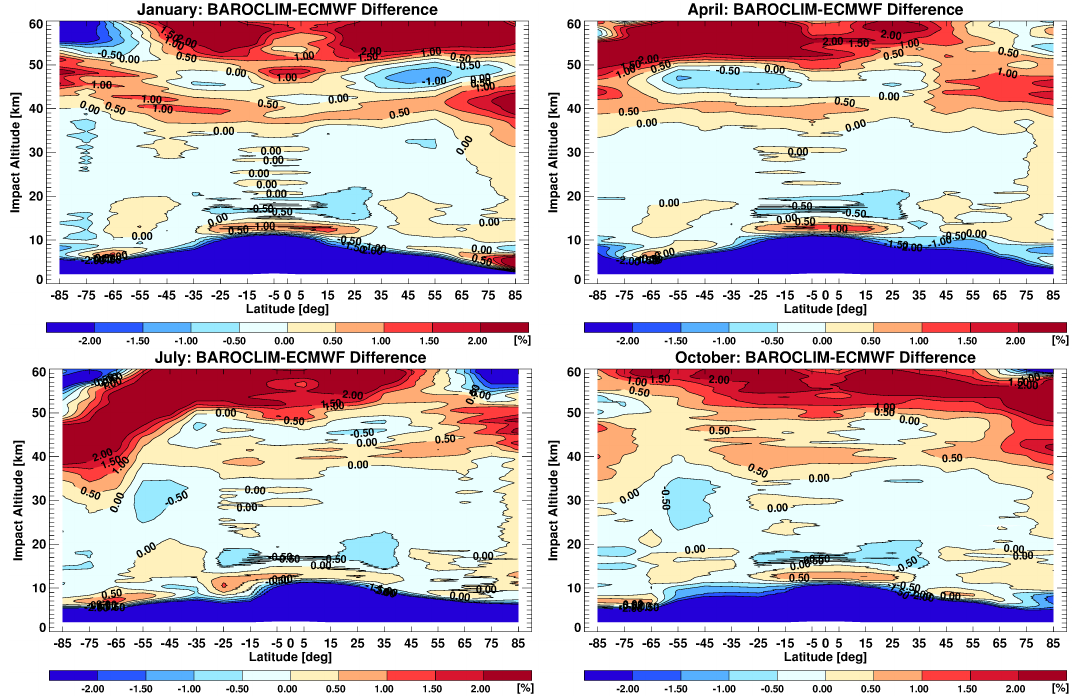
Figure 5. Systematic difference between the BAROCLIM spectral model and ECMWF analyses forward-modeled to bending angle as a function of latitude and impact altitude up to 60km for January (top left), April (top right), July (bottom left), and October (bottom